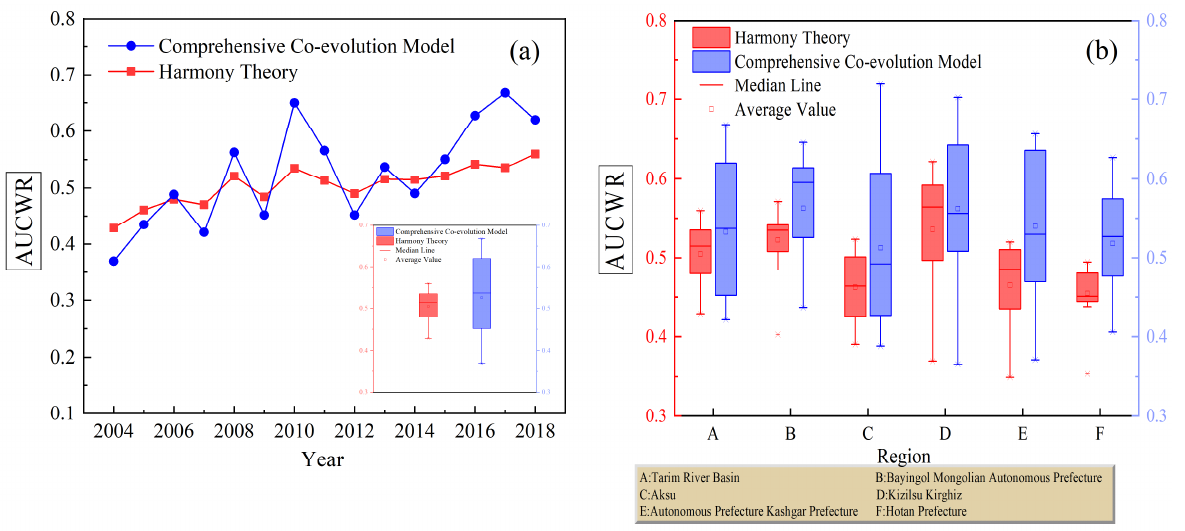
Figure 9. Comparative analysis of AUCWR in the TRB. ( a ): trend comparison of calculation results. ( b ): box-plot of calculation results in different regions.